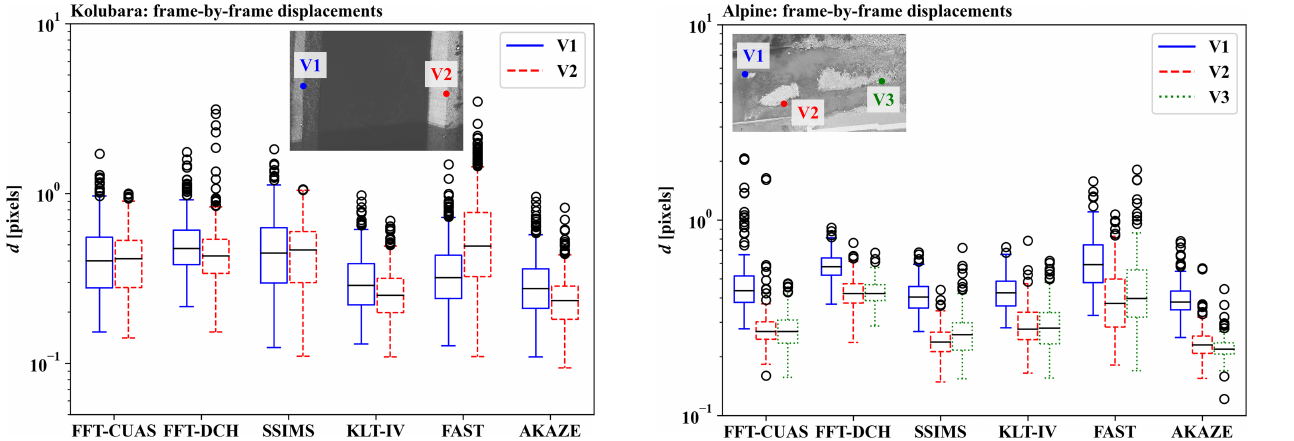
Figure 14. Displacements of validation points relative to their posi- tions in the previous frame for the Alpine river case